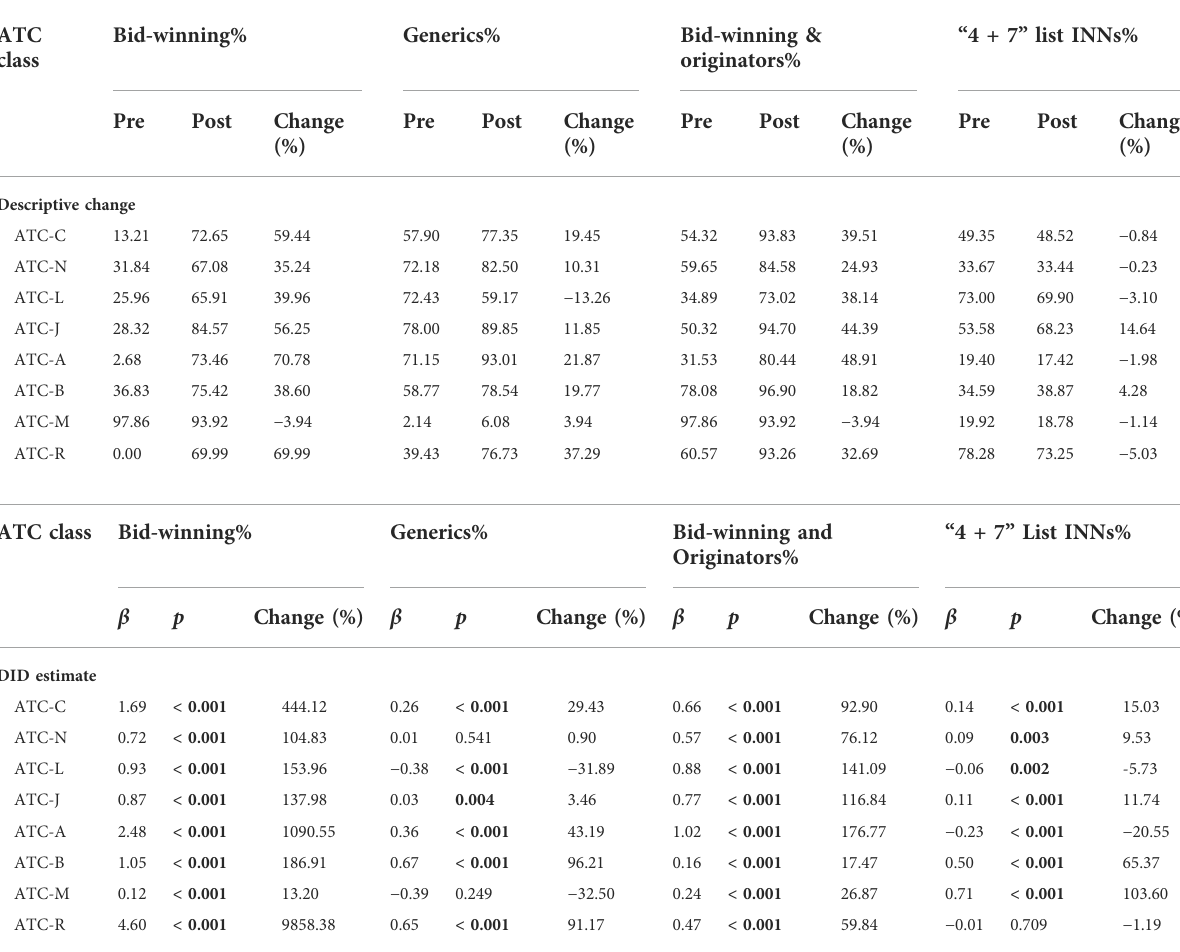
TABLE 6 Subgroup analyses on the impacts of “ 4 + 7 ” pilot on drug use structure by ATC classi fi